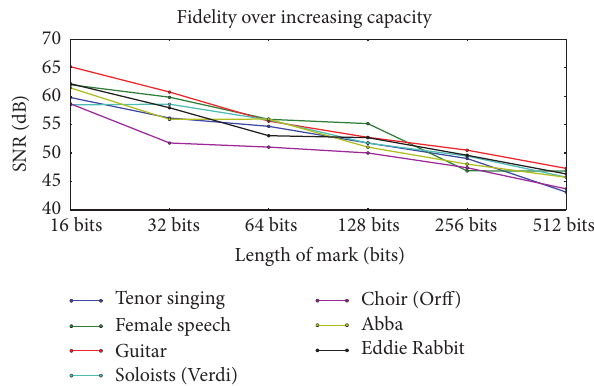
Figure 3: Perceptibility of watermarks with increasing lengths, where 𝐿 = 1500 .